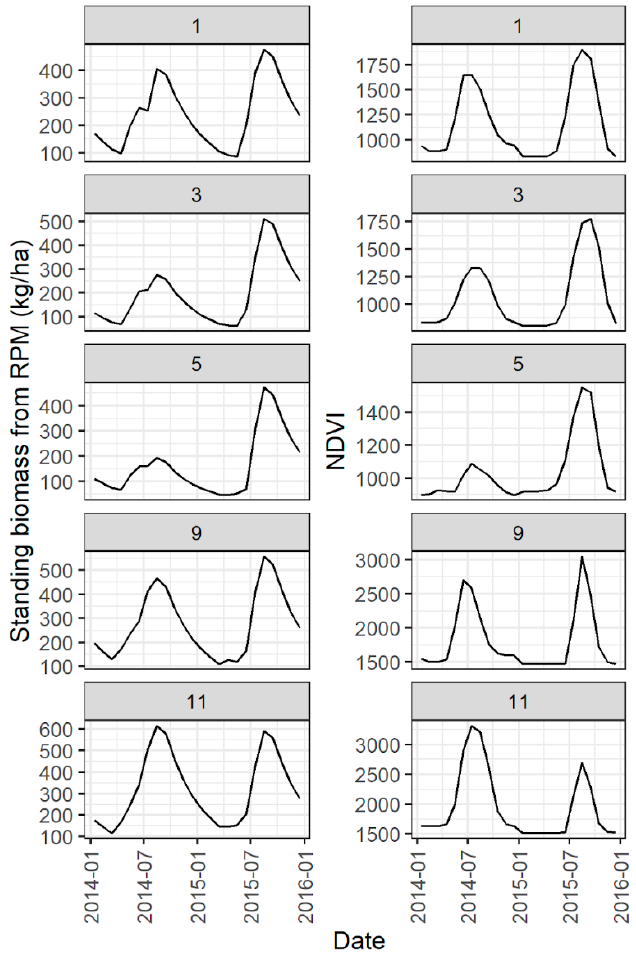
Figure A8. Illustration of comparison of standing biomass time series from RPM with NDVI. This comparison was used to calibrate parameters related to temperature controls on production. Time series are drawn from the pixel in the corresponding spatial dataset that contains the site centroid. Although time series at all 15 sites were compared to each other during calibration, only a subset of sites (sites 1, 3, 5, 9, and 11) are shown here for